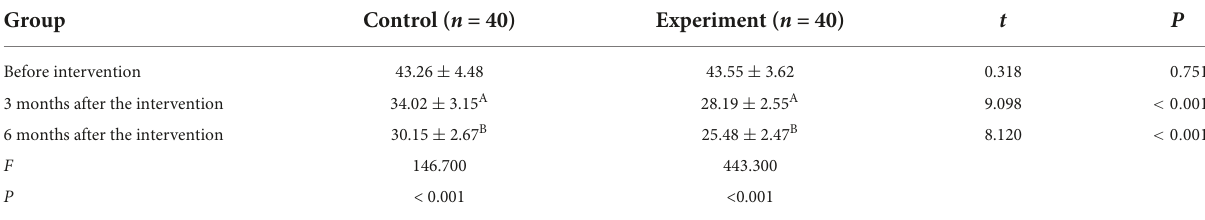
TABLE 2 Comparison of Zarit Caregiver burden interview (ZBI) scores between the two groups before and after intervention (x ± s). Group